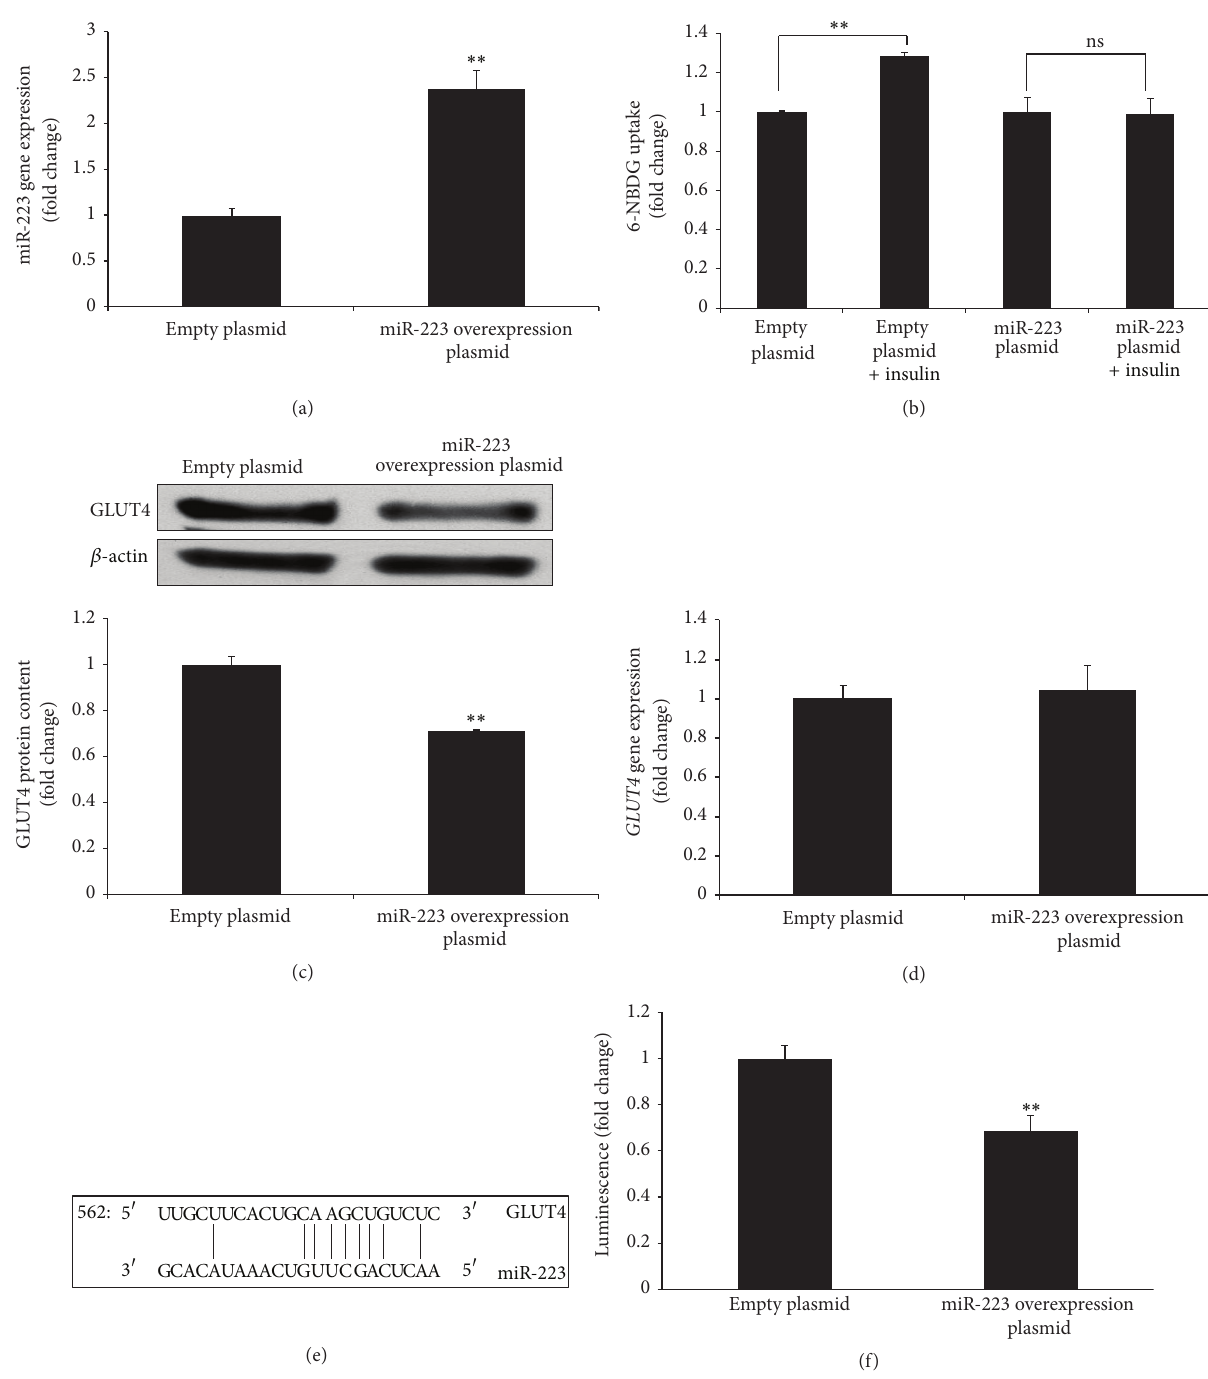
Figure 2: miR-223 regulates GLUT4 expression in human differentiated adipocytes. (a), (c), and (d) Depicted are the miR-223, GLUT4 protein, and GLUT4 gene expression in human differentiated adipocytes after being transfected with miR-223 overexpression plasmid. (b) Depicted is 6-NBDG uptake stimulated by insulin in human differentiated adipocytes after being transfected with miR-223 overexpression plasmid. (e) Depicted is a GLUT4 3 󸀠 UTR predicted binding site for miR-223. (f) Depicted is the GLUT4 3 󸀠 UTR luciferase reporter which was repressed by overexpression of miR-223. ∗∗ 𝑃 < 0.01 comparing to empty plasmid. (In (a), (c), (d), and (f), the comparisons of significance were carried out by unpaired Student’s 𝑡 -test. In (b), the comparison of significance was carried out by ANOVA followed by a posttest by using the Fisher (among groups) and Dunnett (compared to control group)